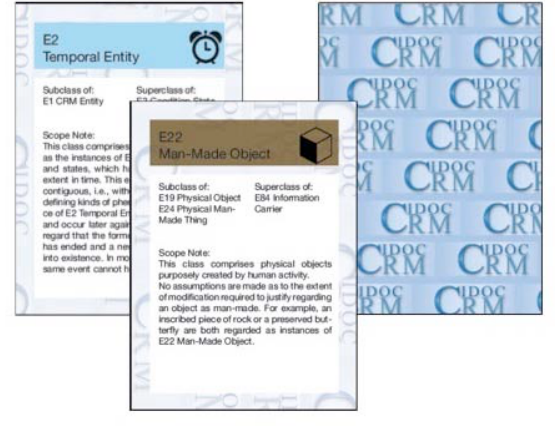
Figure 1. CRM Class